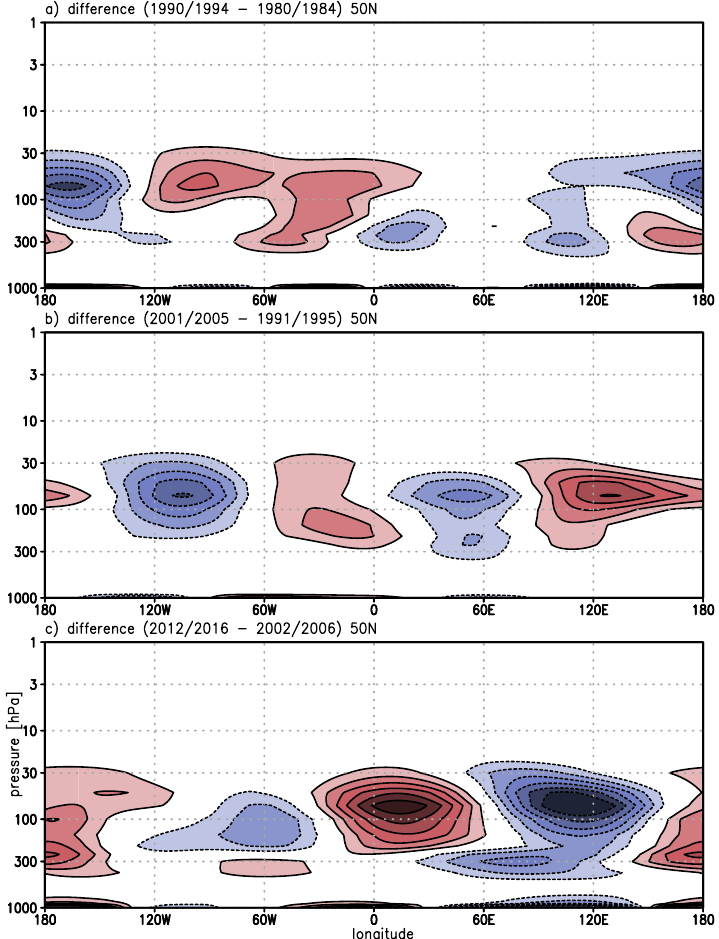
Figure 8. Similar to Figure 7 for the vertical advection (second term of Equation (3)). Absolte values above 0.2 DU/km are shaded with a contour interval